Question: Express in one sentence what the figure is showing.
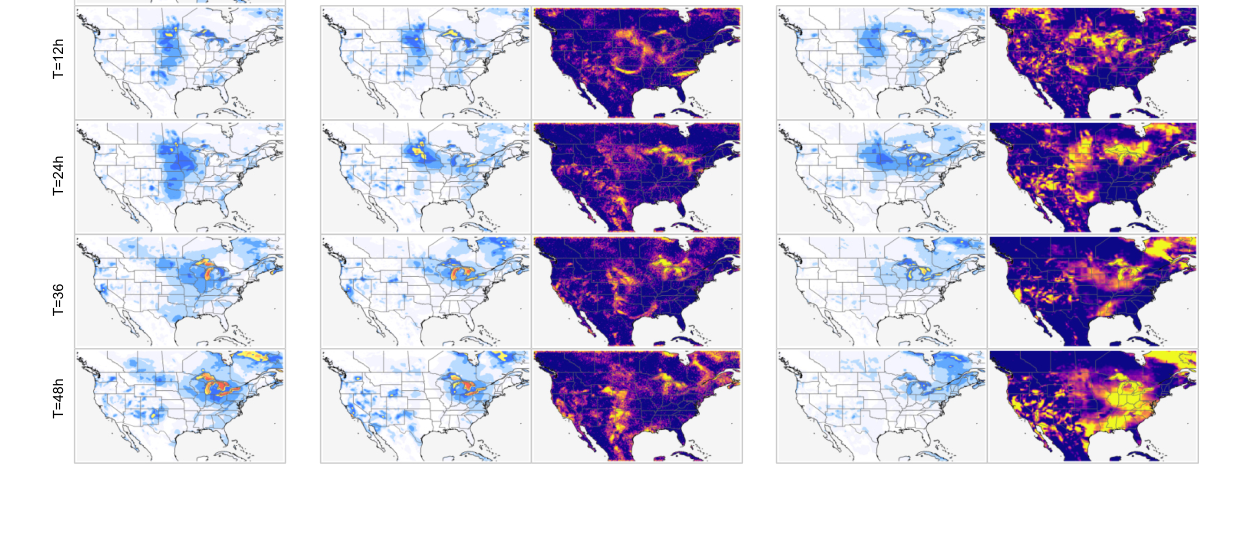
Answer: Additional case studies on ERA5 surface wind prediction. a Case study of the ERA5 wind forecast from 2017-01-02 18:00. The CogDPM successfully prediction the high wind region moving from mideast USA to the Great Lakes. FourCastNet overestimate the moving spatial scale and underestimate its intensity for T=36h and T=48h. The inverse precision field of CogDPM indicate an unpredictable region for mideast USA at T=48h where the prediction neglect. FourCastNet uncertainty focus on the east-south USA at T=48, but is irrelevant with the truth field. Maps produced by the Cartopy package.